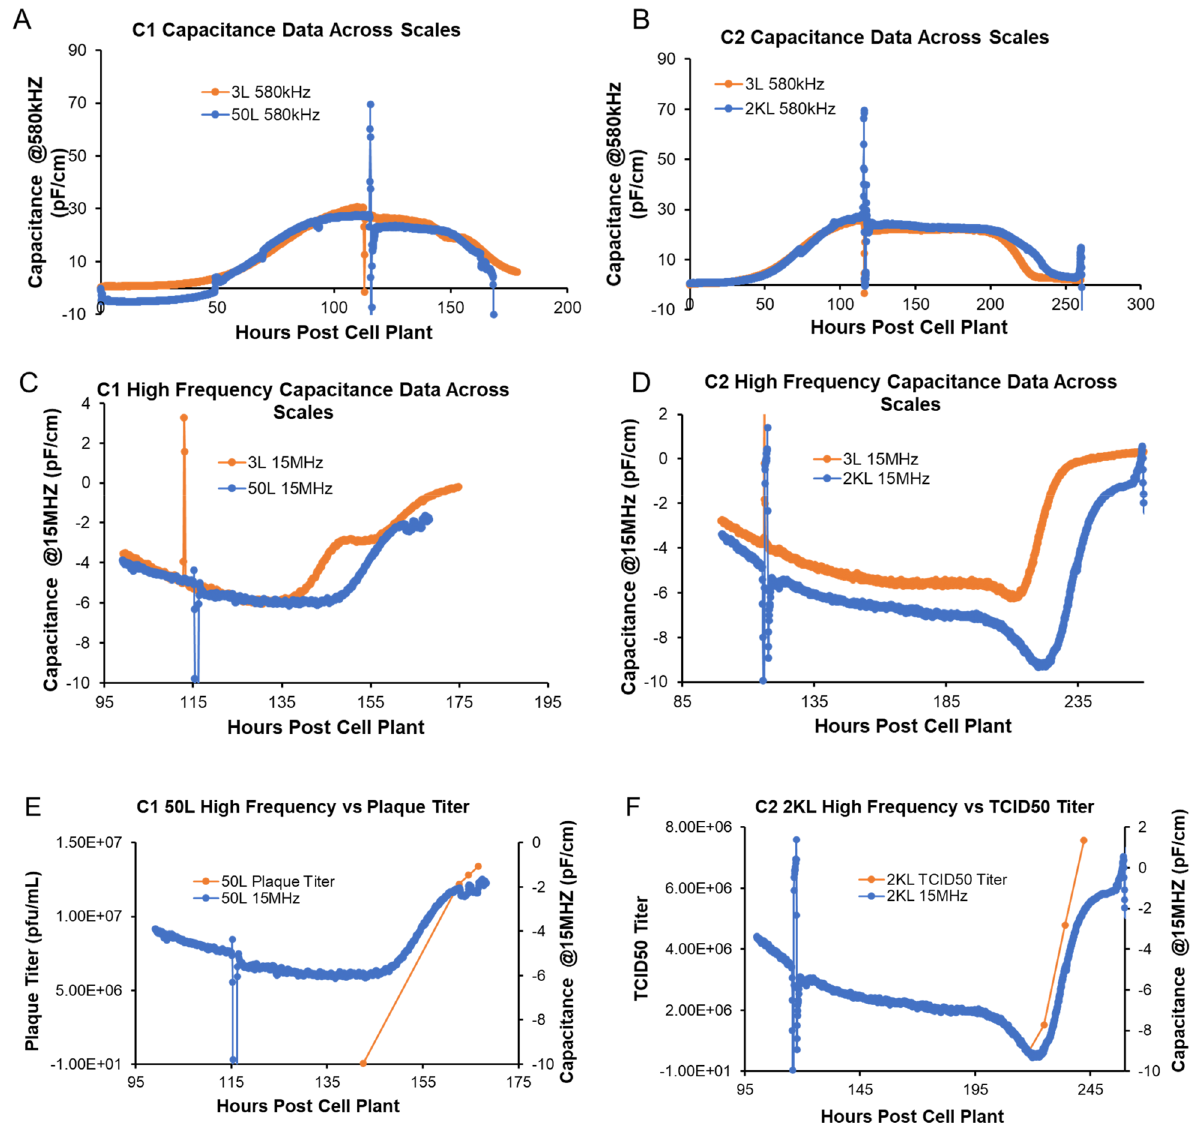
Figure 3. Continuous monitoring of the production process of C1 and C2 vaccine candidates. ( A ) The capacitance profile of C1 vaccine at 580 kHz in a 50L bioreactor (blue) and a 3L bioreactor (orange) in hours post cell plant into the reactors. ( B ) The capacitance profile of C2 vaccine at 580 kHz in a 2000L bioreactor (blue) and a 3L bioreactor (orange) in hours of runtime. ( C ) The capacitance profile of C1 vaccine at 15 MHz in a 50L bioreactor (blue) and a 3L bioreactor (orange) in hours post cell plant into the reactors. ( D ) The capacitance profile of C2 vaccine at 15 MHz in a 2000L bioreactor (blue) and a 3L bioreactor (orange) in hours of runtime. ( E ) The capacitance profile of C1 vaccine at 15 MHz in a 50L bioreactor (blue) and corresponding plaque assay infectivity data (orange). ( F ) The capacitance profile of C2 vaccine at 15 MHz in a 2000L bioreactor (blue) and corresponding TCID50 infectivity data